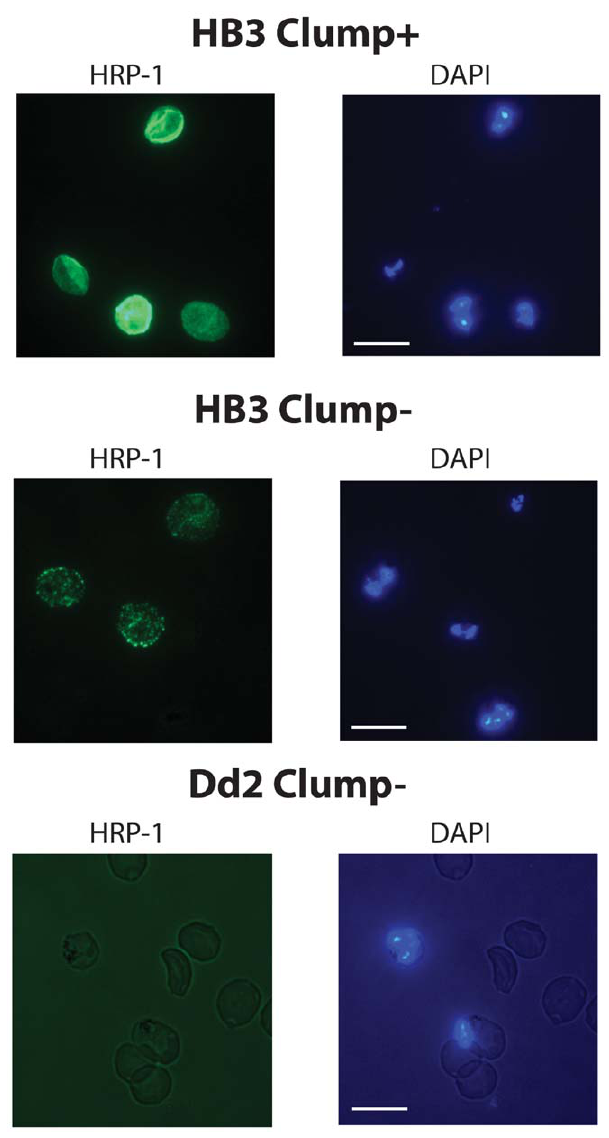
Figure 2. Immunofluorescence assay to detects knobs. Fixed thin blood smears of Clump + and Clump 2 parasites were stained with mAb89 to KAHRP (10 m g/ml in PBS/1%BSA) followed by 1/500 dilution of Alexa Fluor 488 highly cross-absorbed goat anti-mouse IgG in PBS/ 1% BSA (green, left column) plus 1 m g/ml 4,6-DiAmidino-2-PhenylIndole (DAPI) to stain parasite nuclei (blue, right column). No green fluorescence was seen with the knob-negative strain Dd2 (bottom left) nor with the IgG2a isotype control mAb (not shown). In three separate IFAs on parasite cultures from separate days, HB3 Clump + parasites consistently showed markedly brighter staining (top left) than HB3 Clump 2 parasites (middle left). Representative images are shown. Scale bar=10 m M.